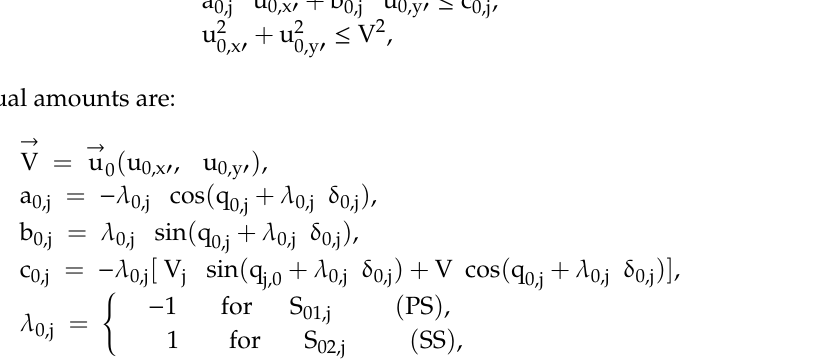
= S or S . j,0 j1,0 j2,0